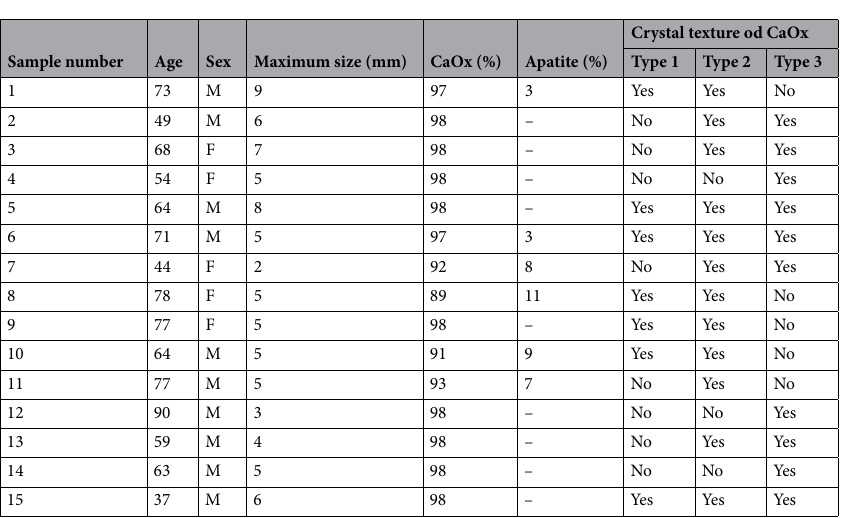
Figure 1. Kidney stone samples analyzed in the present study. ( a ) Sample 1. ( b ) Polarized microscopy image of the thin section of sample 1. ( c ) Enlarged image of the white box area in ( b ). ( d ) Sample 2. ( e ) Polarized microscopy image of the thin section of sample 2. ( f ) Enlarged image of the white box area in ( e ). ( g ) Sample 3. ( h ) Polarized microscopy image of the thin section of sample 3. ( i ) Enlarged image of the white box area in ( h ).